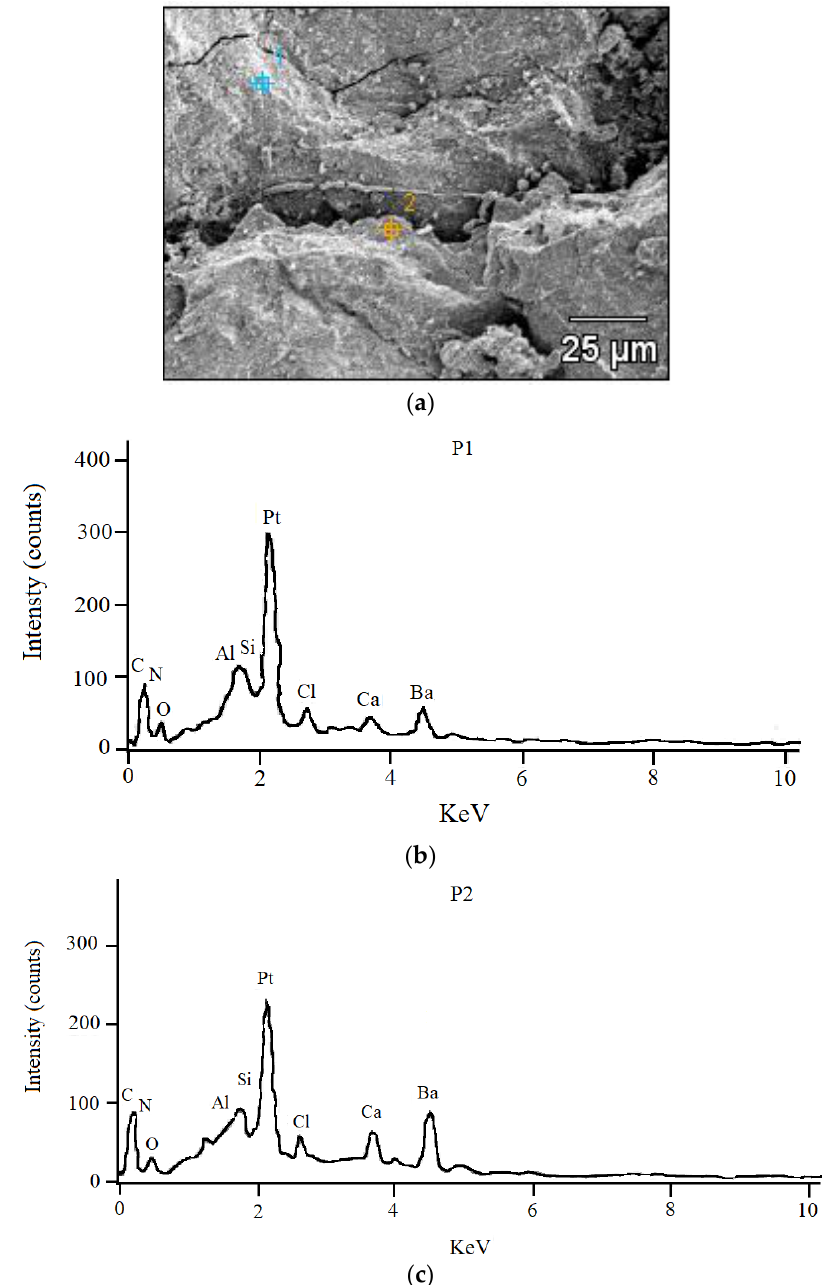
Figure 5. (a) SEM of the surface of a IEP film with 1100× magnification. The EDX is from two film Figure 5. ( a ) SEM of the surface of a IEP film with 1100 × magnification. The EDX is from two film surface analysis locations. ( b ) P1 and ( c ) P2. surface analysis locations. ( b ) P1 and ( c )